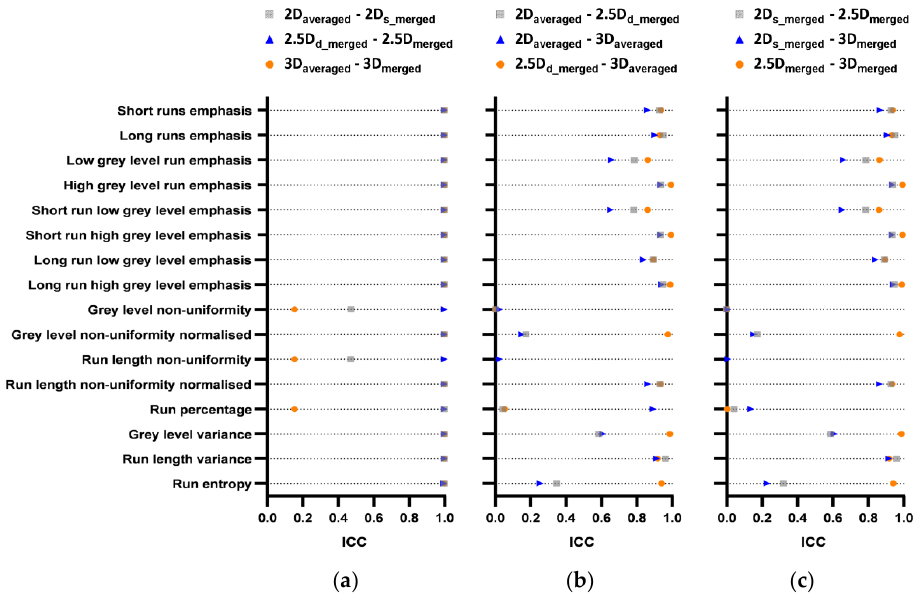
Figure 4. Pairwise ICC for each GLRLM feature extracted from: ( a ) 2D averaged -2D s_merged , 2.5D d_merged -2.5D merged , and 3D averaged -3D merged , ( b ) 2D averaged -2.5D d_merged 2D averaged -2.5D merged , and 2.5D d_merged -3D averaged , and ( c ) 2D s_merged -2.5D merged , 2D s_merged -3D merged , and 2.5D merged -3D merged .